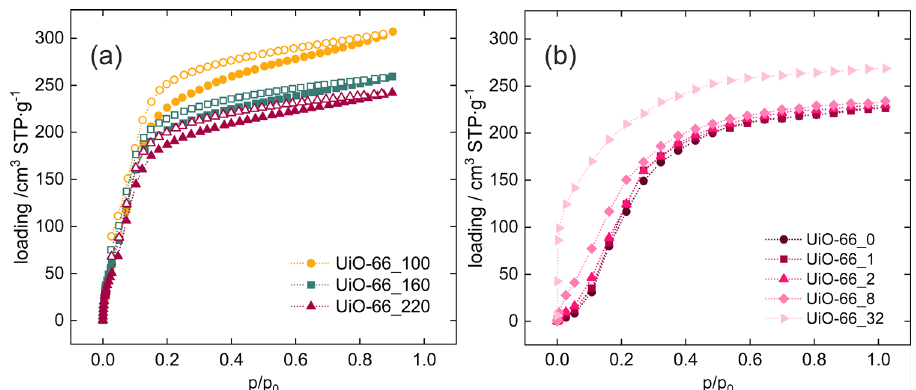
Fig. 3 Adsorption isotherms of methanol in UiO-66. a From experiment, b from calculations, measured/computed at 27 °C. Closed symbols stand for adsorption, open for desorption.